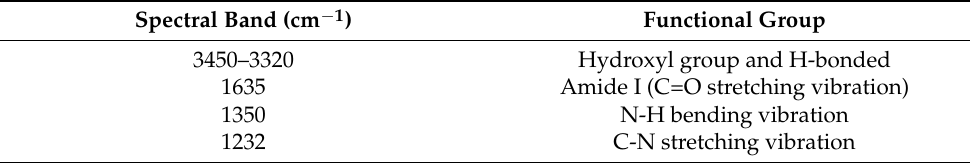
Table 2. FT-IR spectral analysis of bacterial supernatant-synthesized silver nanoparticles proved the presence of functional groups at a spectral band range of 4000 to 400 cm − 1 .